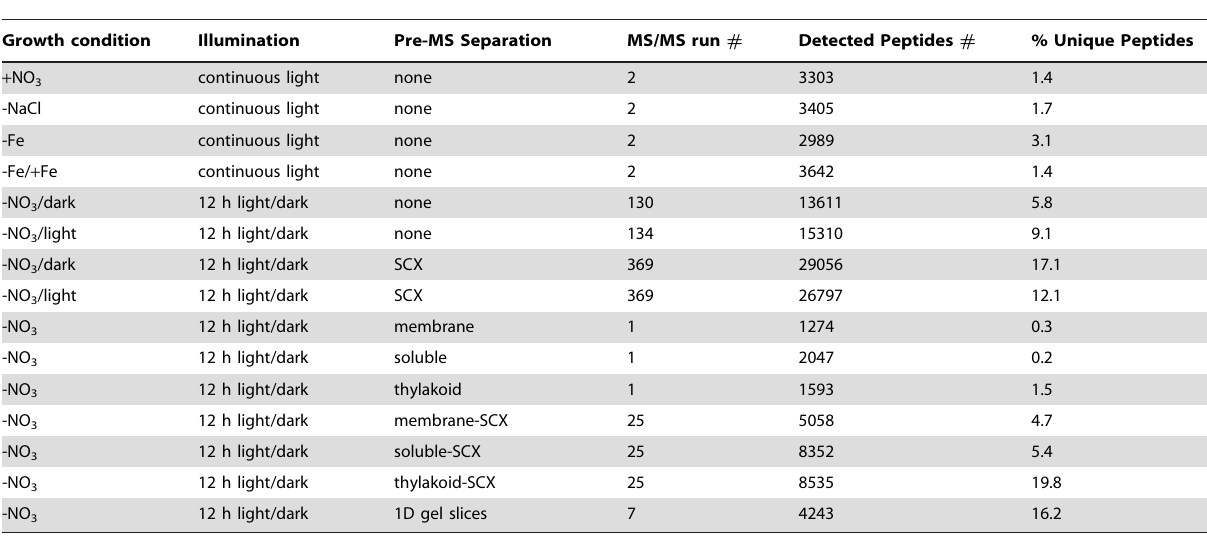
Table 1. Data sets contributing to the Cyanothece 51142 proteome